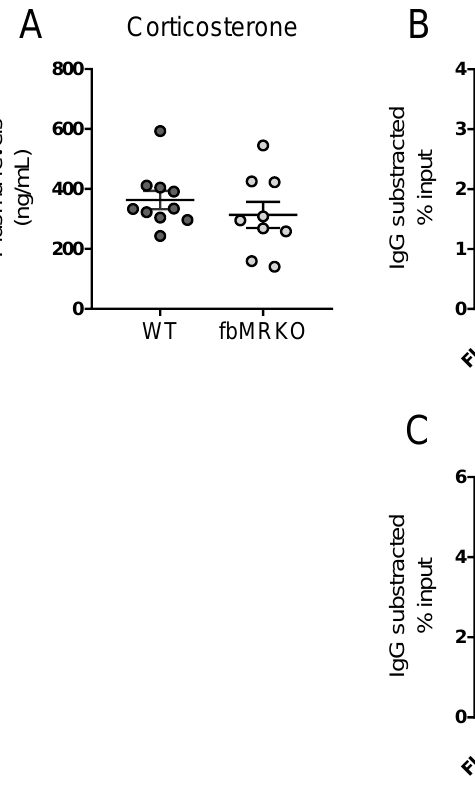
Figure 1. ( A ) Corticosterone levels of wild-type (WT) and forebrain-specific mineralocorticoid receptor (MR) knockout (fbMRKO) mice. In these mice chromatin immunoprecipitation coupled with quantitative polymerase chain reaction (ChIP-qPCR) measurements for ( B ) glucocorticoid receptor (GR) and ( C ) Neurod2 were performed. For each gene, the corresponding immunoglobulin G (IgG) background signal is subtracted from detected binding levels, expressed as the percentage of immunoprecipitated DNA. The binding sites near Fkbp5 , Klf9 , Per1 , Kif1c and Zfp219 are joint MR/GR loci, while Rilpl1 has been identified as an MR-specific target [9] (separated by the right dotted line). Genes are further sorted based on the absence ( Fkbp5 , Klf9 , Per1 ) or presence ( Kif1c , Zfp219 , Rilpl1 ) of a NeuroD binding sequence near the MR binding site (separated by the left dotted line). *** p <